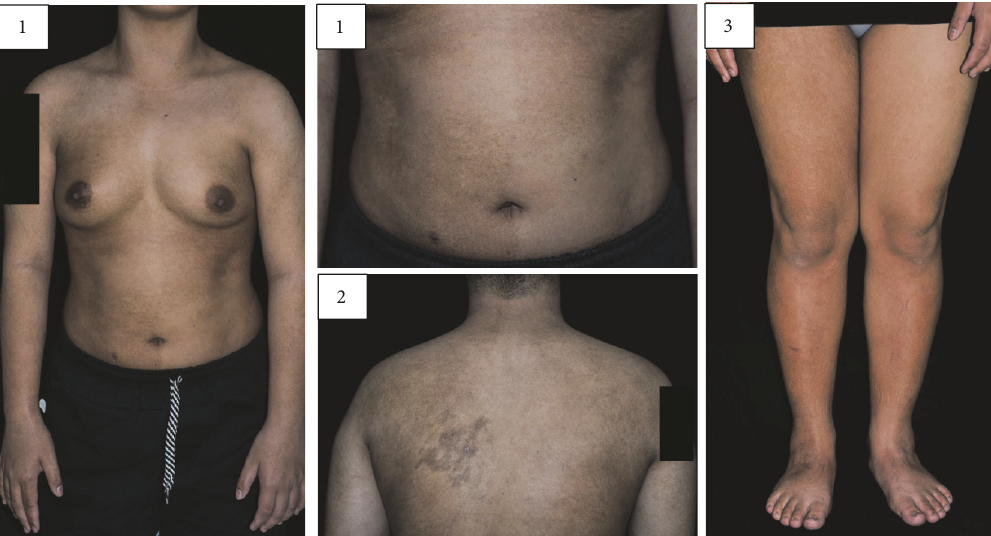
Figure 1: Multiple Becker nevi on (1) anterior trunk resembling a checkerboard mosaic pattern, (2) left upper back extending toward left shoulder, and (3) the whole right leg. Slight smaller left breast and right leg circumference are